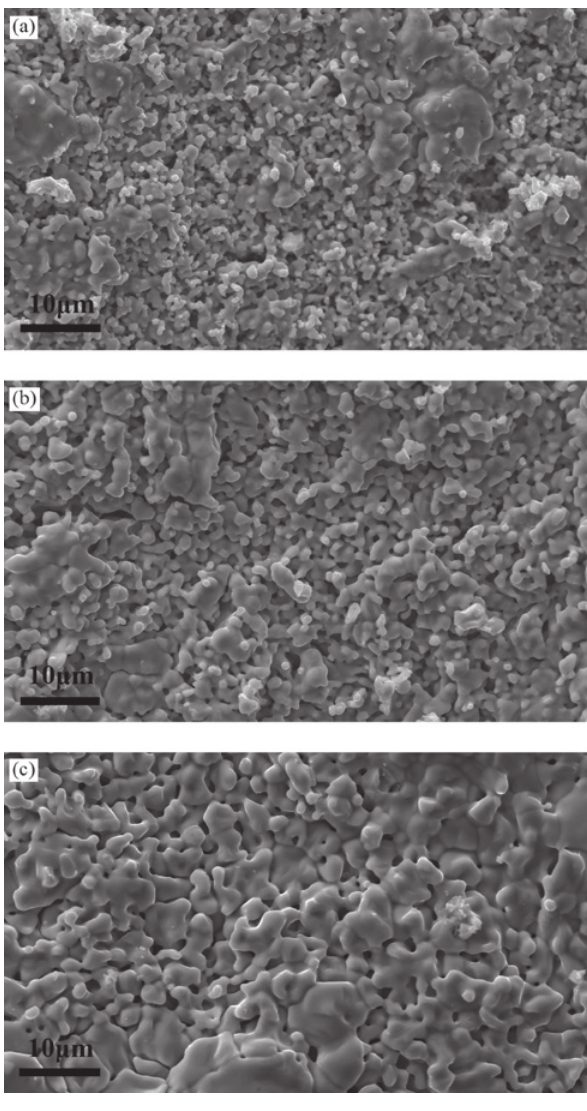
Fig. 4: SEM photos of products (Ba 2 Fe 2 O 5 ) at (a) 1273 K, (b) 1373 K, and (c) 1473